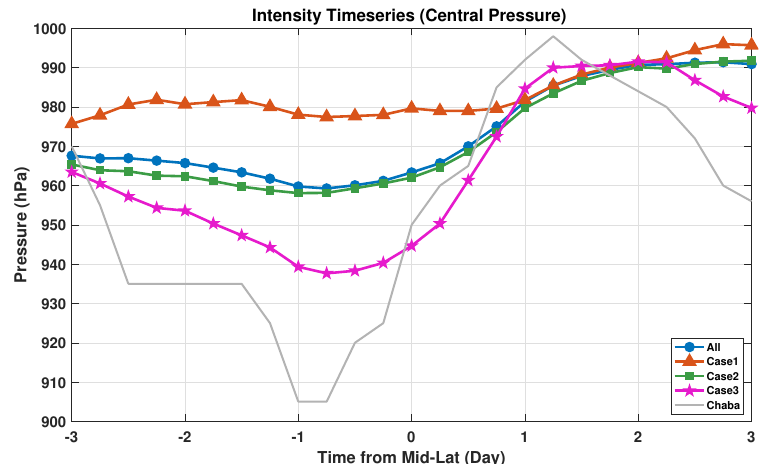
Figure 3. The temporal changes in the average central pressure of TCs before/after the TCs pass 30° N for all and three cases. The zero at the x-axis indicates the time when the TCs pass 30° N and negative (positive) values represent the time before (after) the TCs pass 30° N. The light gray line represents the central pressure of Typhoon Chaba (2016) that is the representative TC in case 3 discussed in Section 3.2.